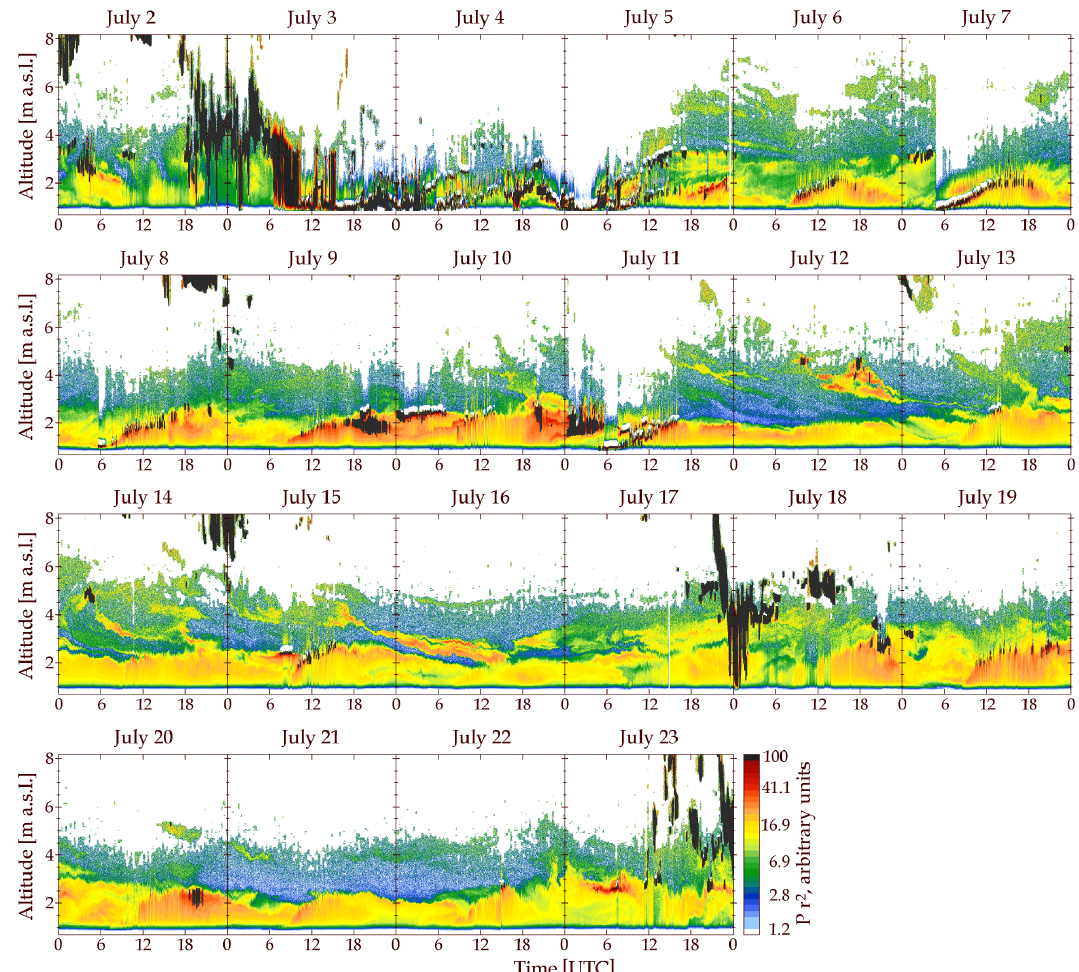
Figure 3. Range-corrected backscatter signal ( P(r)r 2 ; logarithmic colour code) measured by ceilometer over Leutkirch (southern Germany) from 2 to 23 July 2013. Areas with low signal-to-noise ratio are masked white. On several days the Canadian smoke layers filled a consider- able part of the free troposphere above the mixing layer (up to 2km, marked by yellow to reddish